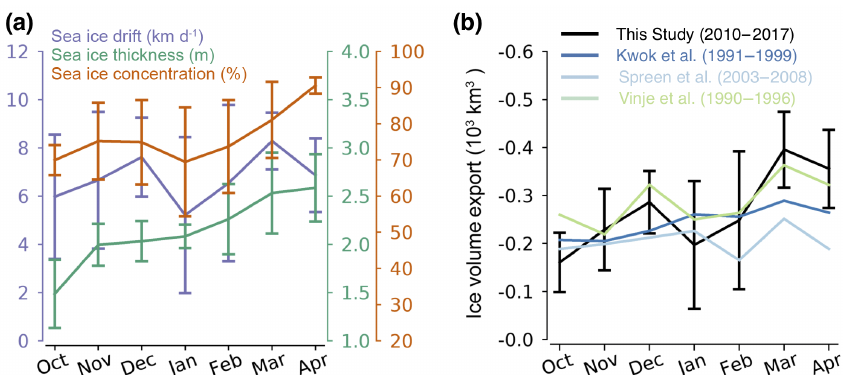
Figure 8. (a) Mean monthly sea ice drift, thickness and concentration at the Fram Strait gate over the years 2010–2011 and 2016–2017 with corresponding standard deviations. (b) Mean monthly ice volume export through the Fram Strait from this study and from Spreen et al. (2009), Kwok et al. (2004) and Vinje et al. (1998), covering different